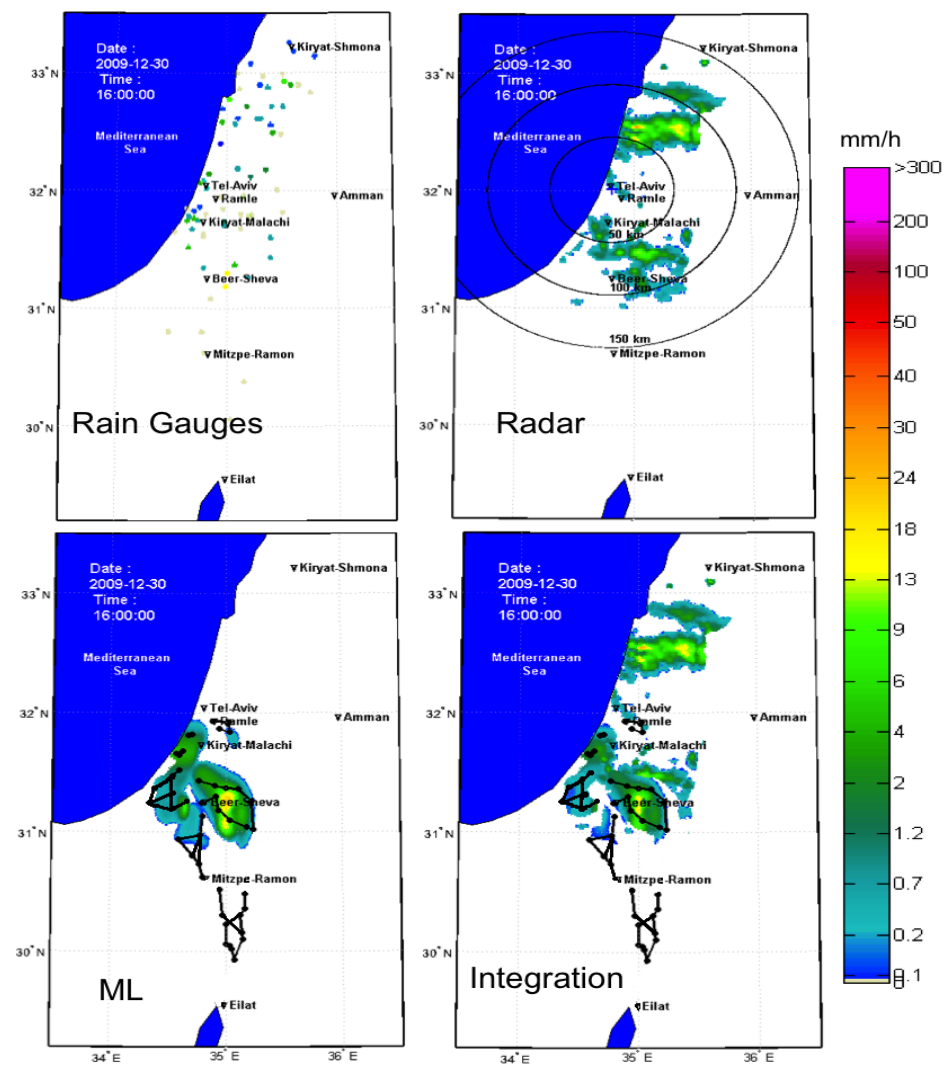
Figure 6. Example of the rain field reconstruction for the 30 December 2009 rain event (event 3) at 16:00IDT. Top left: rain gauges. Top Fig. 6. Example of the rain field reconstruction for the 30-Dec-2009 rain event (event (3)) at 16:00. Top left: right: radar. Bottom left: ML. Bottom right: the Rain gauges. Top right: Radar. Bottom left: ML. Bottom right: The proposed integration.